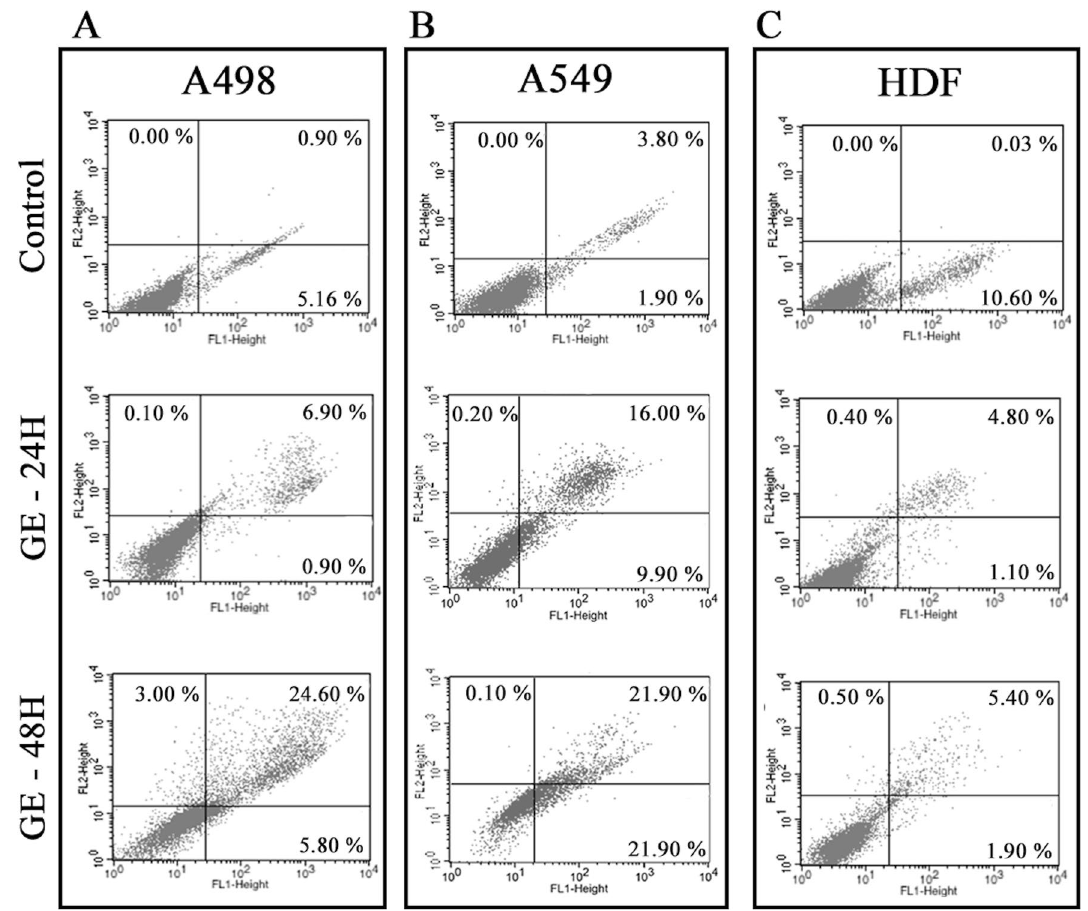
Figure 4. Annexin V/pI costaining assay was performed on human kidney carcinoma A-498, human lung carcinoma A-549 and human dermal fibroblast (HDF) cells in order to detect apoptosis after the treatment of 50 µg/ml garlic SEVs for 24 and 48 h. Early and late apoptosis quantifications were presented. Data expressed as the mean ±